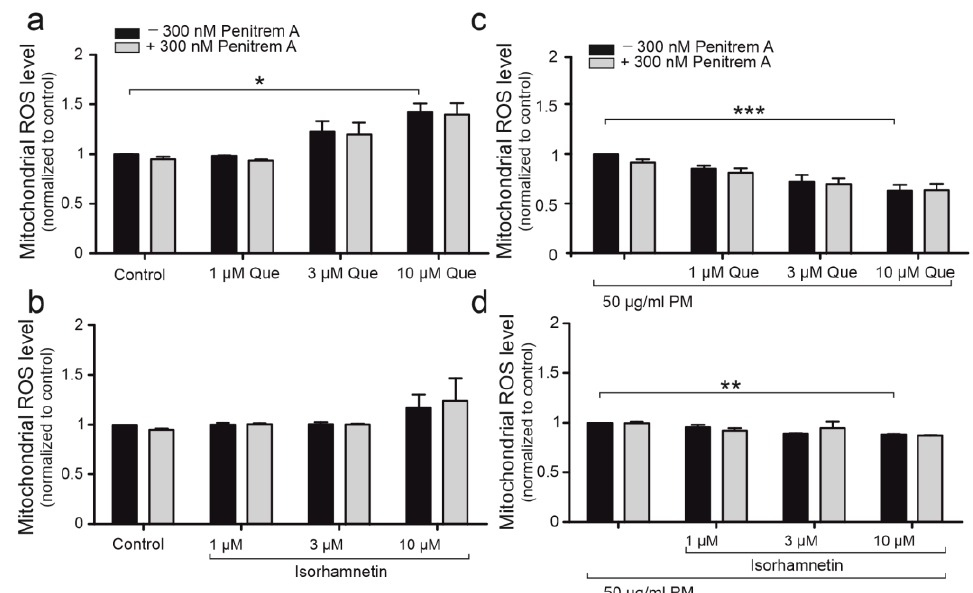
Figure 6. The influence of quercetin and isorhamnetin on mitochondrial ROS levels. It has been presented effect of quercetin (1, 3, 10 µM) ( a ) and influence of isorhamnetin (1, 3, 10 µM) ( b ) on mitochondrial ROS level measured using MitoSOX fluorescent dye. The effect of application of 50 µg/mL PM witch quercetin (1, 3, 10 µM) ( c ) and isorhamnetin (1, 3, 10 µM) ( d ) on mitochondrial ROS level were reported. The influence of 300 nM Penitrem A is represented by gray bars. Data is normalized to the control values. All results are represented by means ± SD, n = 3. Statistical significance was determined at p < 0.05 (*), p < 0.01 (**), p < 0.001 (***) by one-way ANOVA.